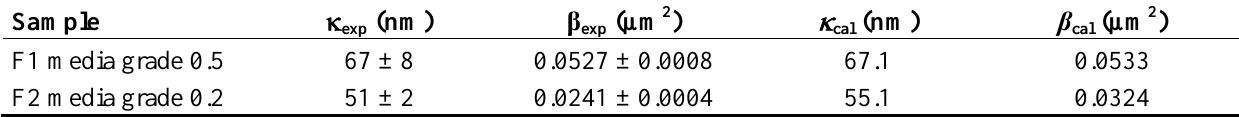
Table 1. Experimental and calculated effective transport properties of porous metal filters.